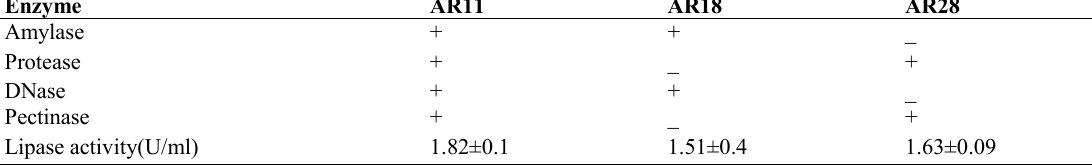
Table 2. The hydrolytic activity of halophilic culture collection strains, the lipase activity (U/mL).